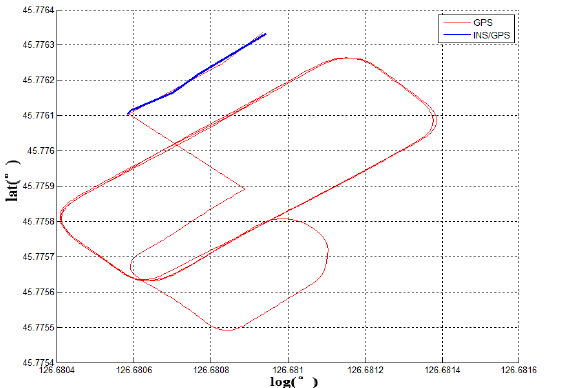
Figure 11. long-term position